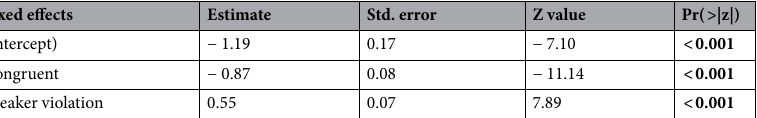
Table 5. Summary of Frequentist Logistic Linear Mixed Effects Model for Experiment 1 with full violation as the reference level. Significant values are in